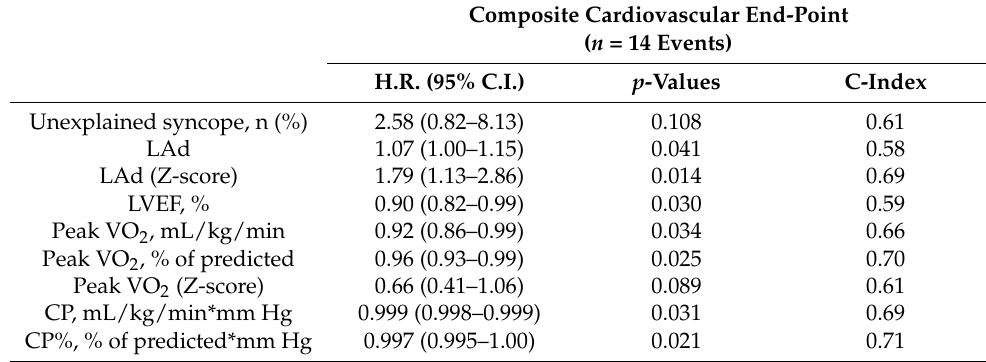
Table 5. Significant univariate Cox proportional survival analysis according to the main variables for the pre-specified cardiovascular end-point.